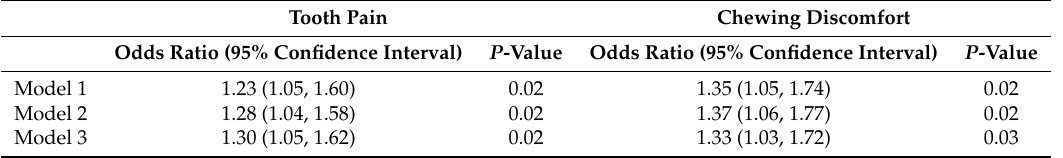
Table 3. Adjusted odds ratios and 95% confidence intervals of the individuals with tooth pain or chewing discomfort in multivariate logistic regression models in the presence of menstrual cycle irregularity.